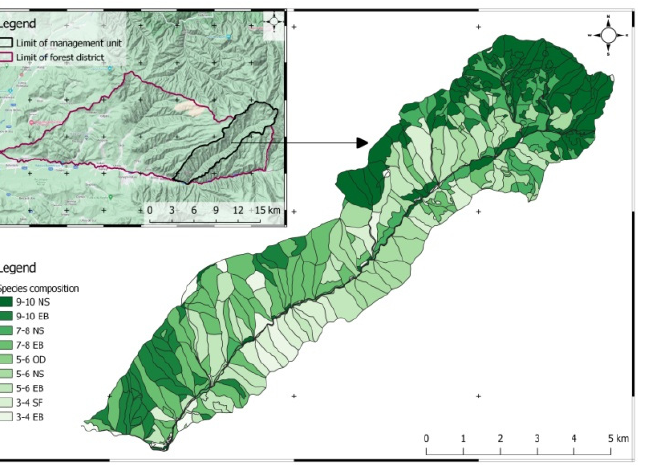
Figure 1. Location of the study area showing establishment of the investigated management unit.